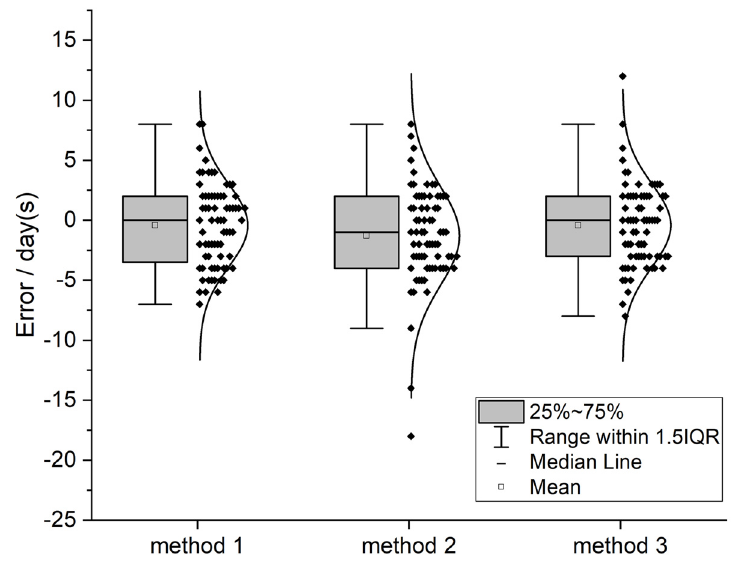
Figure 6. Box plots showing error distributions of the three sampling methods used to